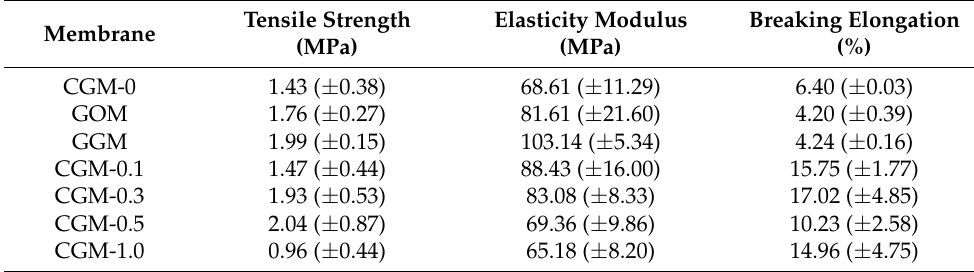
Table 2. Comparison of mechanical strength of ultrafiltration membranes.